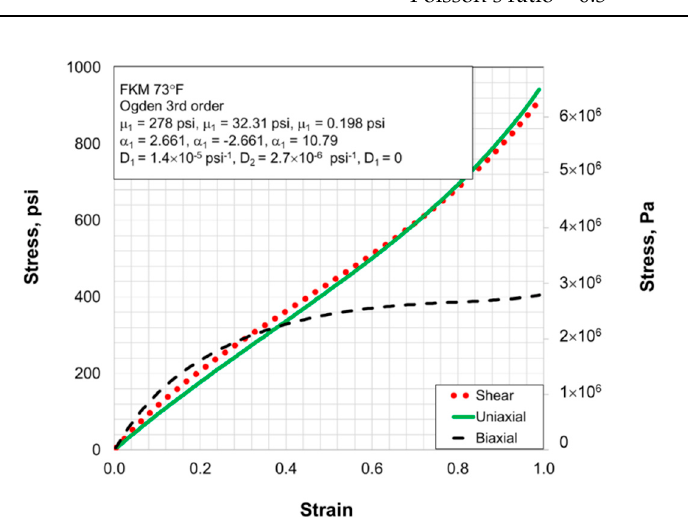
Table 1. Material properties used in the FEA